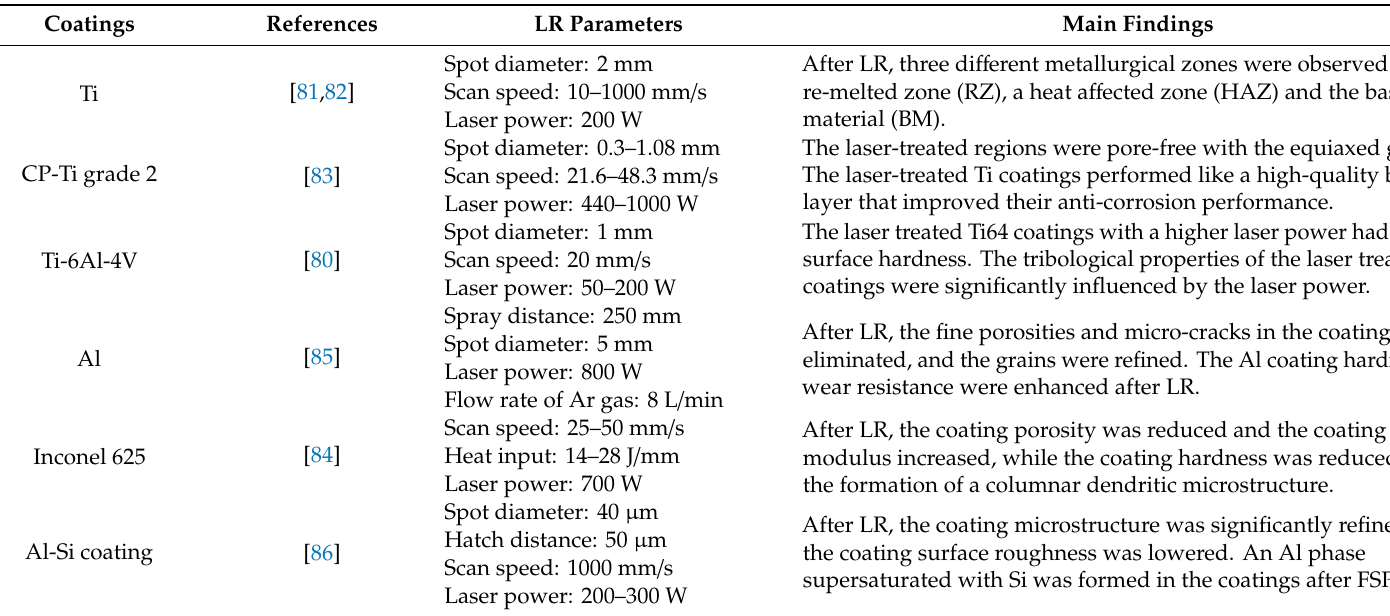
Table 4. E ff ect of laser re-melting on cold sprayed